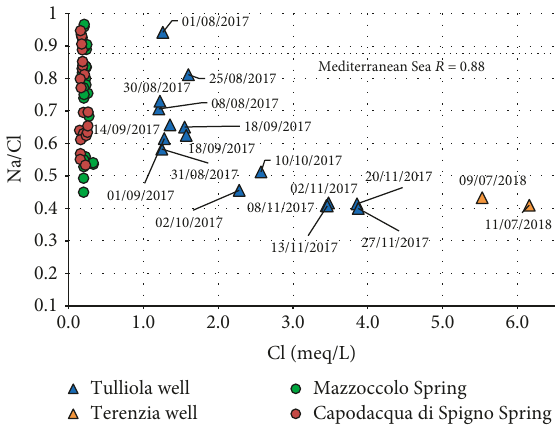
Figure 9: Scatter plot of Cl vs.